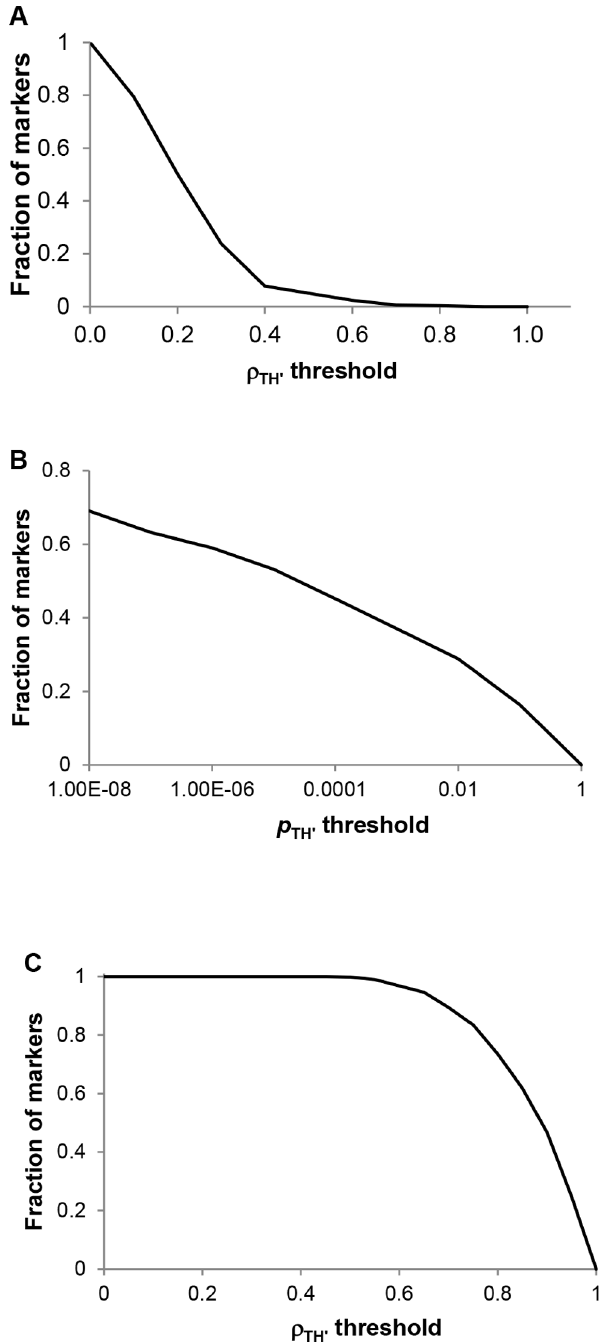
Figure 3. Correlations and p -value of markers. A) Fraction of markers satisfying j r 0 j j w r TH . B) Fraction of markers whose p -value is greater than p TH . C) Fraction of markers with max j = k j r jk j w r TH .